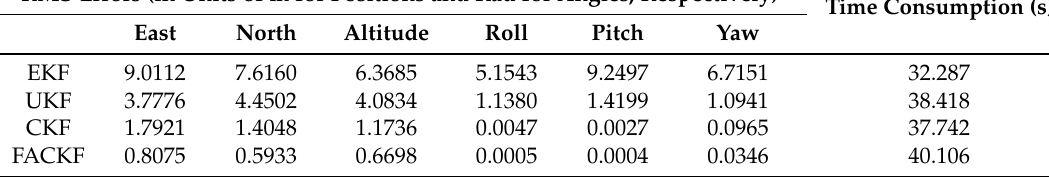
Table 7. Summary of RMS errors and the time consumption for Scenario 2. RMS Errors (in Units of m for Positions and Rad for Angles,